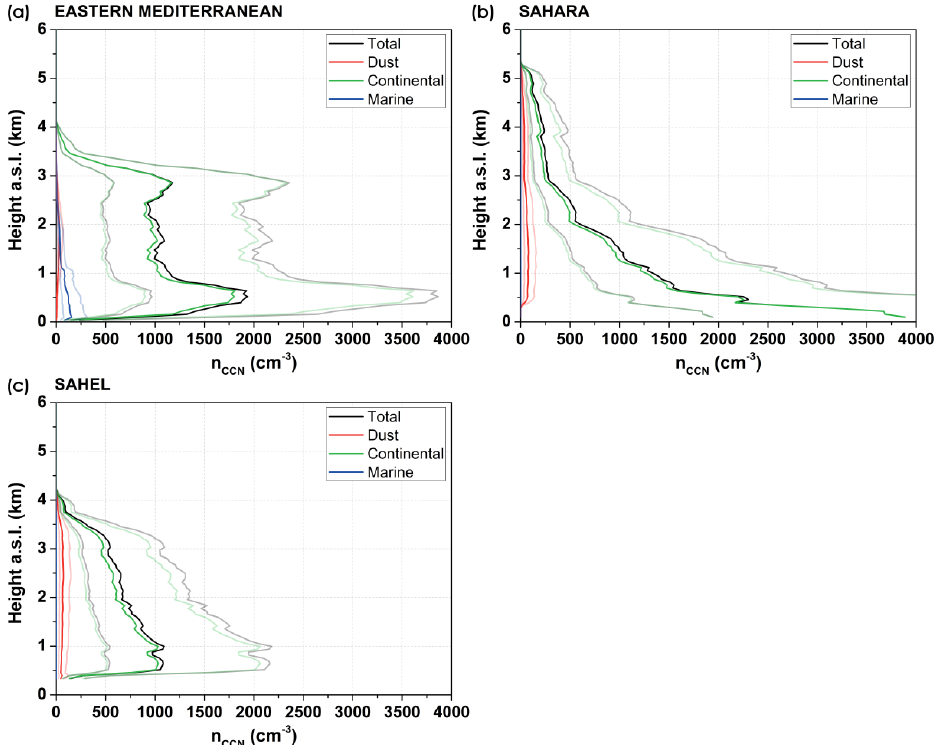
Figure 8. Profiles of CALIPSO-derived CCN concentrations for the total aerosol, for mineral dust, continental aerosols, and marine aerosols at a supersaturation of 0.15% for the Eastern Mediterranean ( a ), Sahara ( b ), and Sahel regions ( c ). Transparent color lines indicate an uncertainty of a factor of two.